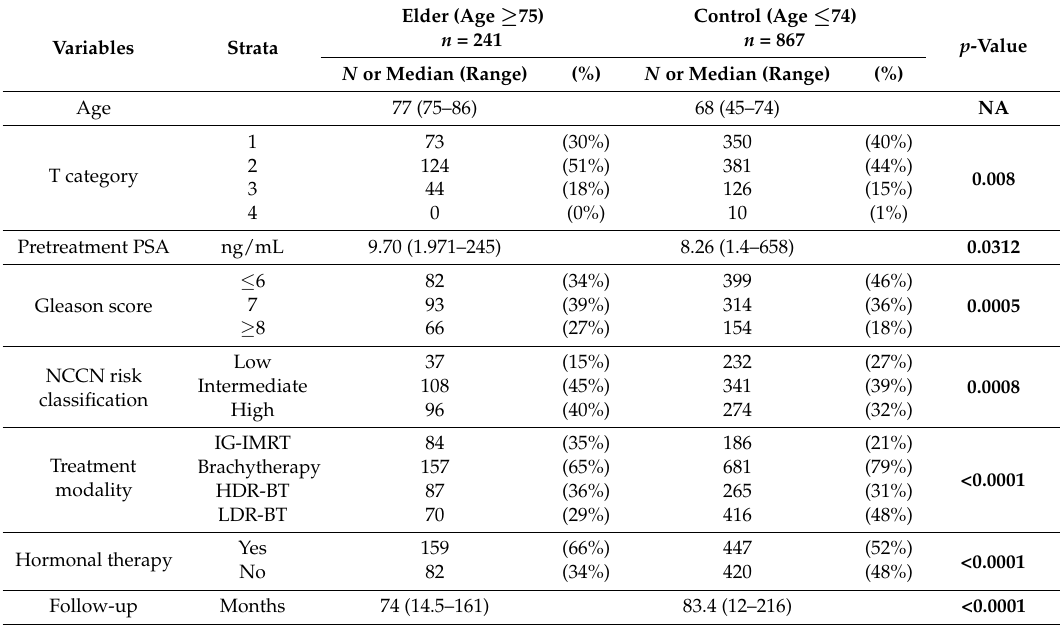
Table 1. Characteristics and treatment factors of